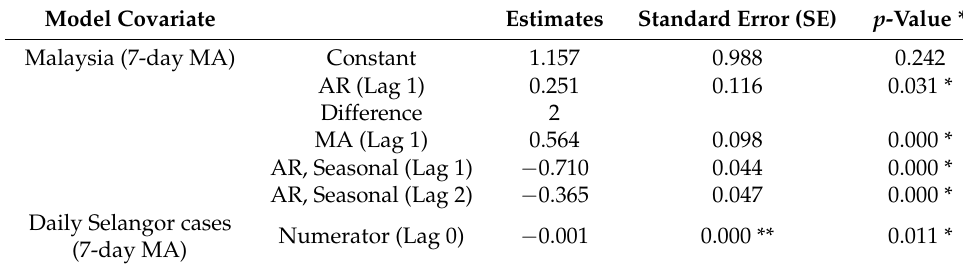
Table 2. Model parameters for SARIMA (1,2,1) (2,0,0).